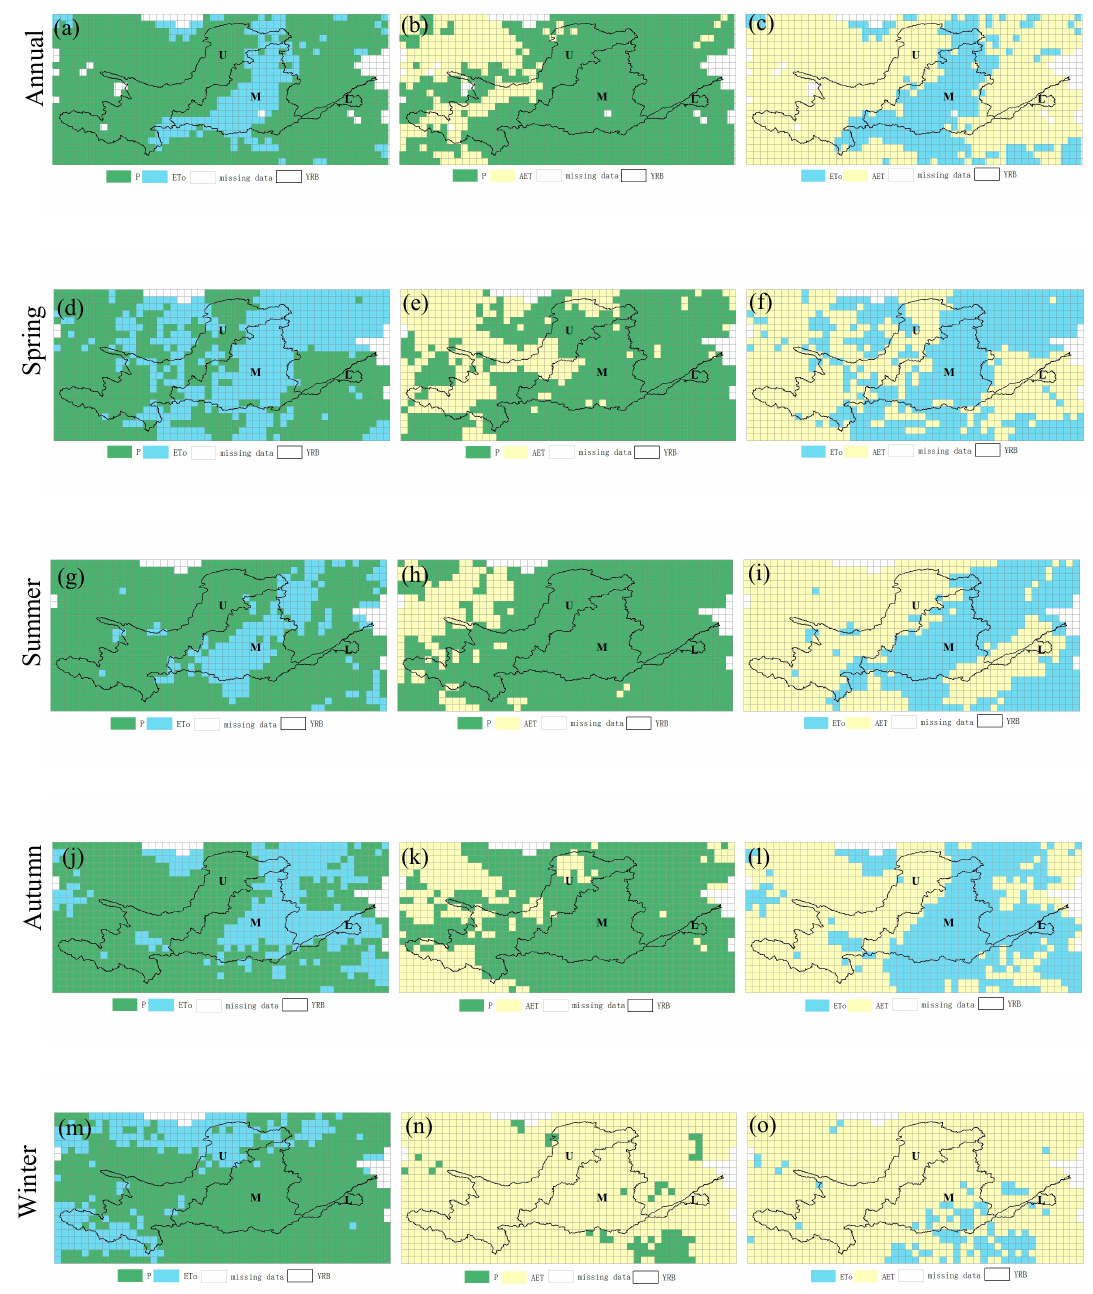
Figure 8. Spatial distribution of dominant factor that mainly affected the sc-PDSI on annual and seasonal time scales during 1951–2017 in YRB ( a – o ) (Green in the watershed indicates that the main driver of drought is P, blue indicates that the main driver is ET 0 , and yellow indicates that the main driver is AET).